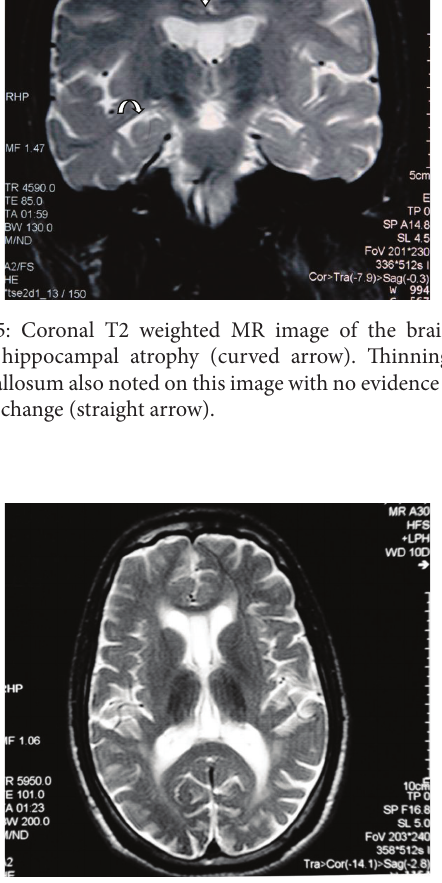
Figure 6: Interval axial weighted MR image of the brain following a six months of abstinence shows no significant interval change in the thalamic hypointensity or the periventricular white matter and pos- terior internal capsule hyperintensity, despite clinical